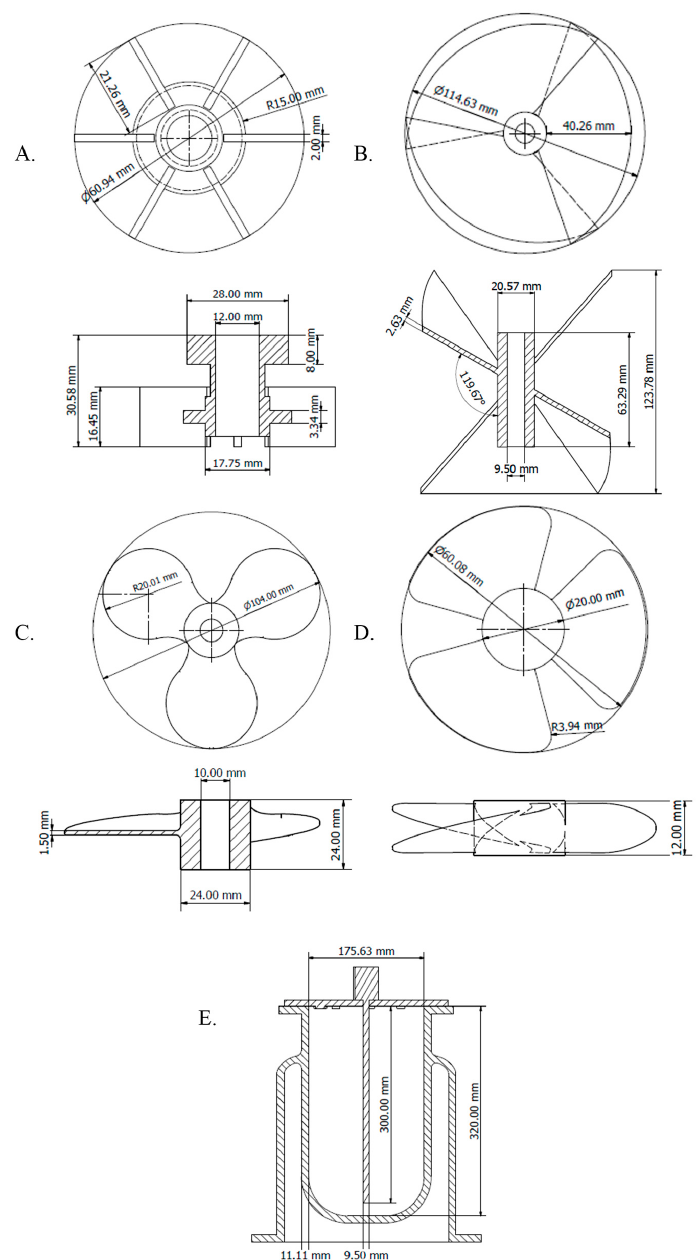
Figure A1. Isometric view of inclined: Rushton impeller ( A ); Paddles impeller ( B ); Propeller impeller: Figure A1 . Isometric view of inclined: Rushton impeller (A); Paddles impeller (B); Propeller impeller: default ( C ); Propeller impeller: small design ( D ); and Brunswick Bioflo / CelliGen 115 bioreactor vessel ( E default (C); Propeller impeller: small design (D); and Brunswick Bioflo/CelliGen 115 bioreactor vessel (E).